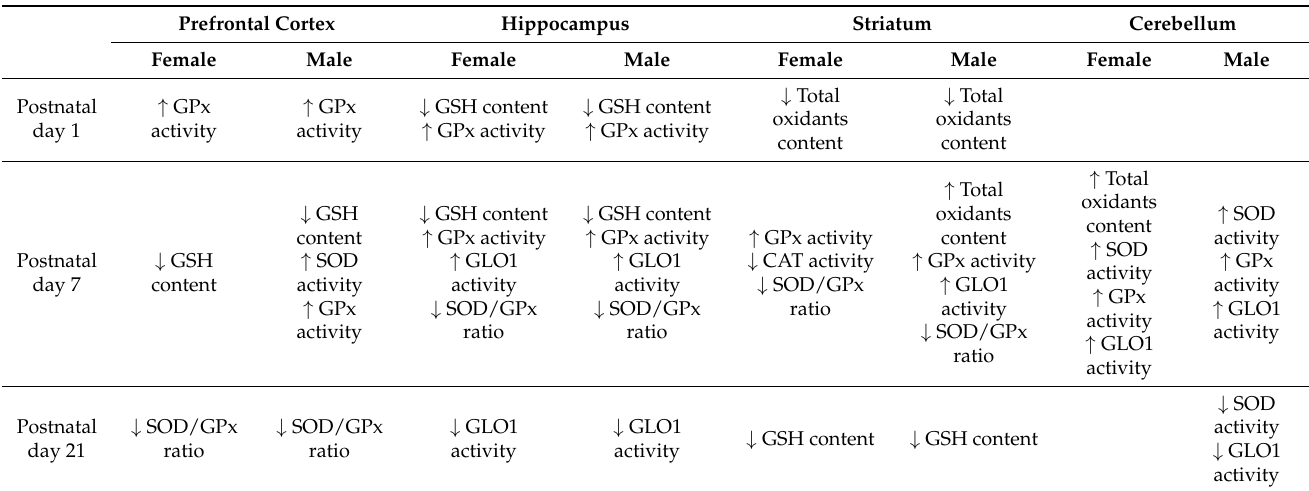
↓ : means the given parameter was significantly lower in the naringin pups compared to the control pups, ↑ : means the given parameter was significantly higher in the naringin pups compared to the control